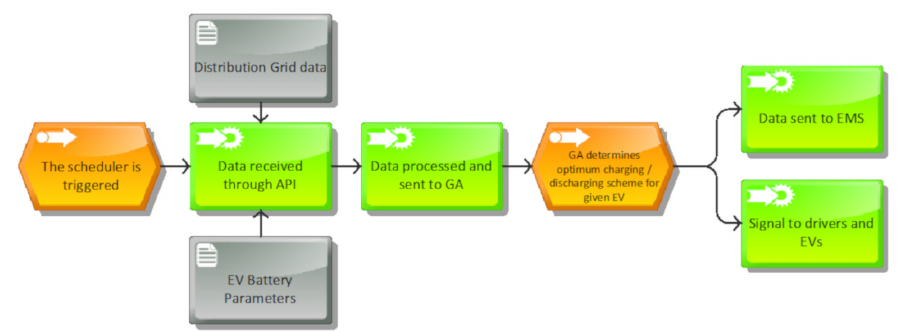
Figure 17. Genetic algorithm for online operations.